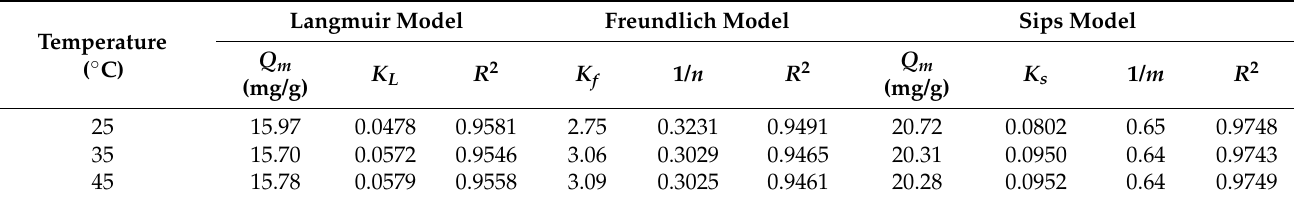
Figure 14. Adsorption isotherm fitting curves of As(III) on MGOCS composite. Table 2. Isotherm parameters of As(III) adsorption on